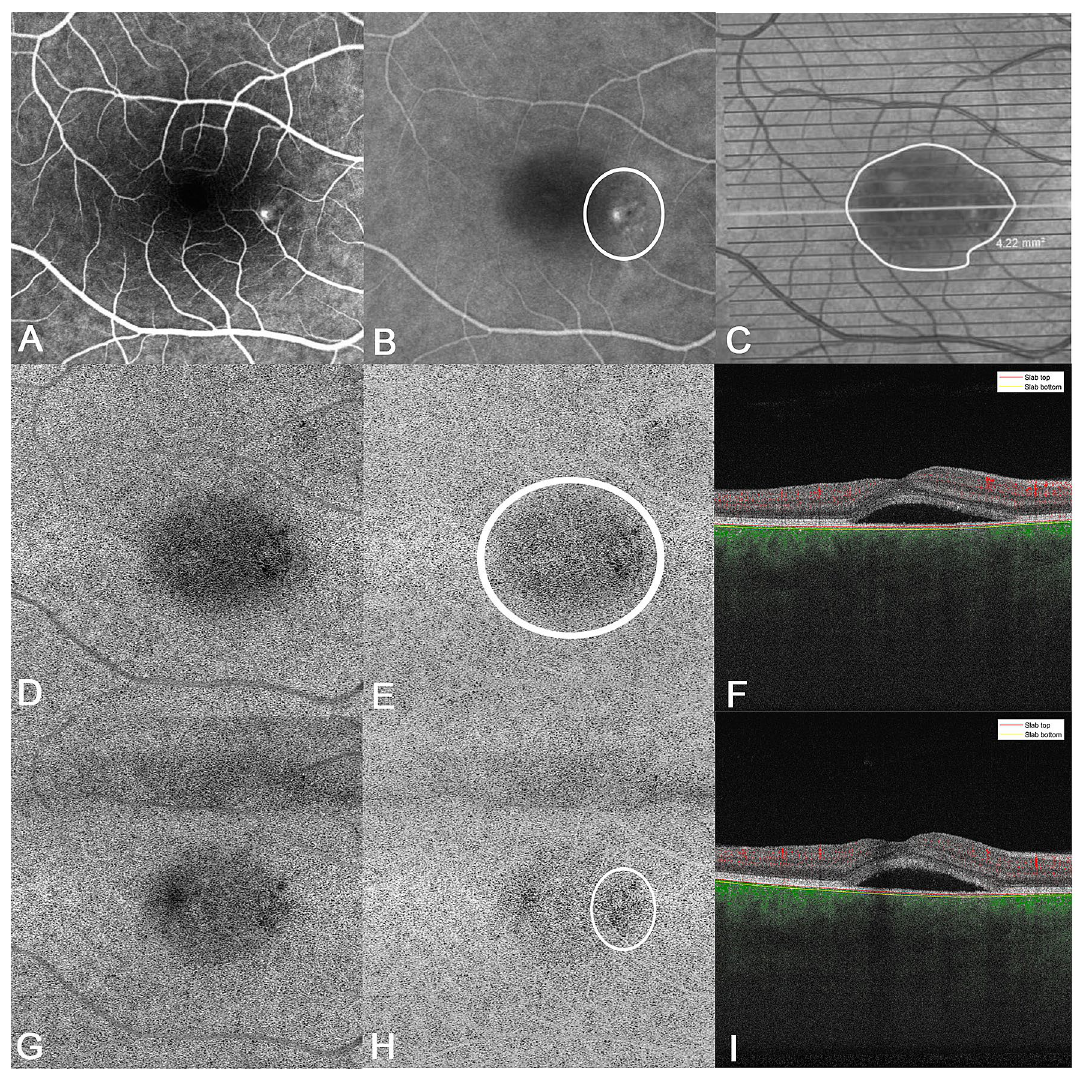
Figure 1. Example of choriocapillaris analysis. ( A ) Fluorescein angiogram showing leakage point, ( B ) indocyanin green angiogram (ICGA) showing hypofluorescent areas and leakage point marked with the white circle, ( C ) en face OCT image with the marked SRF area, ( D ) angiography image of the choriocapillaris slab at baseline prior to compensation and projection removal. Projection artifact of the SRF is visible. ( E ) Angiography image of the choriocapillaris slab at baseline after compensation and projection removal. There is a diffuse gray area visible (white circle), ( F ) central B-scan at baseline showing SRF. The slabs mark the segmentation lines of the choriocapillaris, ( G ) angiography image of the choriocapillaris slab at month one prior to compensation and projection removal. Projection artifact of the SRF is visible. ( H ) Angiography image of the choriocapillaris slab at month one after compensation and projection removal. The gray area is smaller compared to baseline, although SRF is still present. The white circle marks lower perfusion in the choriocapillaris, corresponding area of the leakage point and hypoflourescence on ICGA (image B). ( I ) Central B-scan at month one showing SRF. The slabs mark the segmentation lines of the